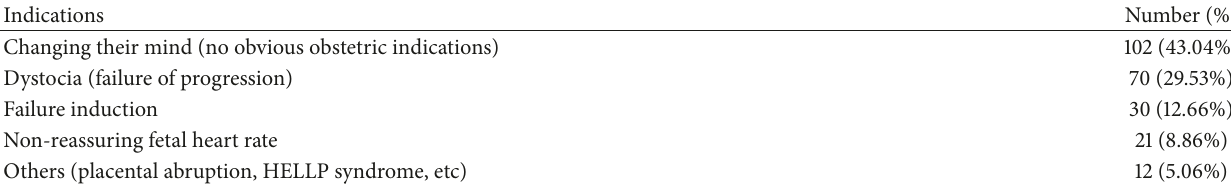
Table 3: Indications for cesarean section among women with failed TOLAC (237